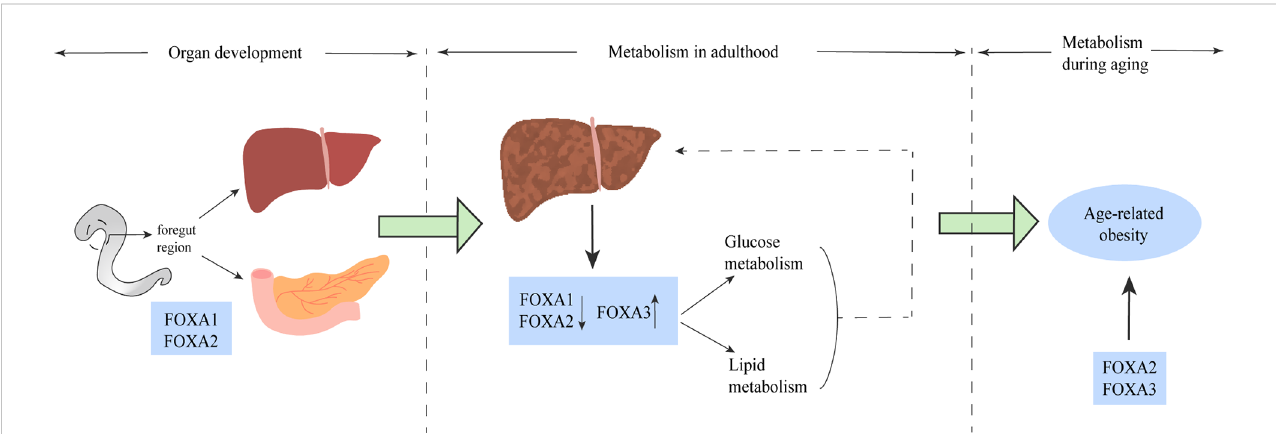
FIGURE 6 The FOXA family plays a role in multiple stages of life. FOXA1 and FOXA2 play a major role in the phase of liver and spleen development. The role of the FOXA family for glucose metabolism and lipid metabolism is well established (solid line), and altered FOXA expression has been shown in the liver of both patients and animal models of NAFLD, and some of these alterations have been proven to have impact on the pathogenesis of NAFLD (dashed line). In older age, mainly FOXA2 and FOXA3 dominate the development of age-related